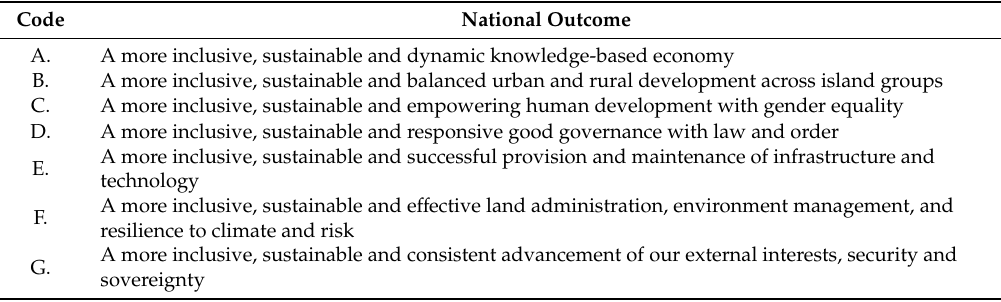
Table 7. The seven planned National Outcomes of TSDFII [12].